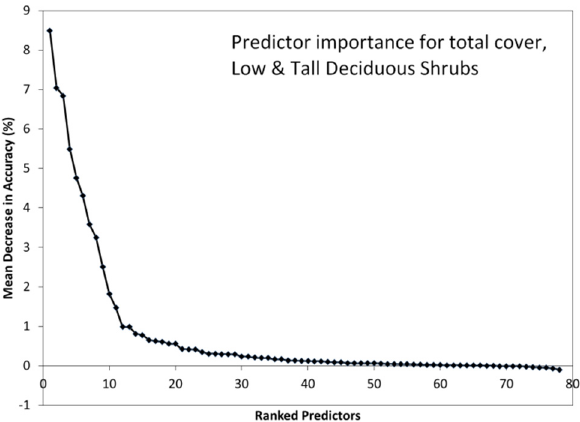
Figure 10. Plot of unbiased variable importance determined by conditional random forest, by predictor rank for total cover of low and tall shrubs, North Slope, Alaska.